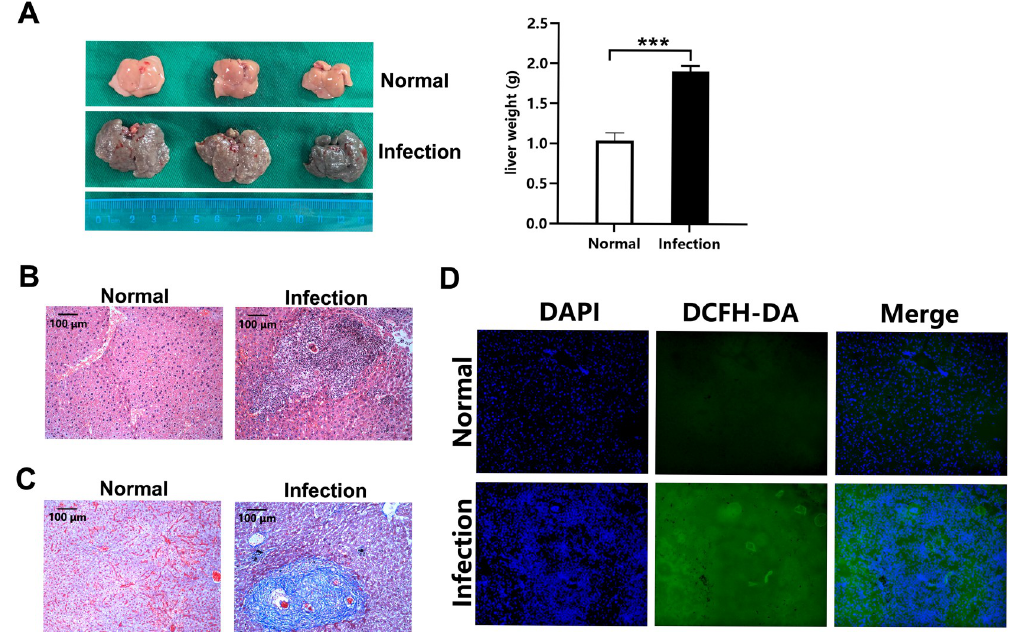
Fig 1. Increased ROS are accumulated in the livers of S . japonicum -infected mice. (A) Representative images of mouse livers from normal (uninfected) or S . japonicum -infected mice are shown. The bar graphs show the average liver weight (g) of mice. (B and C) Representative images of H&E (B) or Masson’s trichrome (C) stained liver sections obtained from normal or infected mice are shown (original magnification, 100-fold; scale bar, 100 μ m). (D) Immunofluorescence of frozen liver sections from normal or infected mice for nuclei using DAPI (blue) and ROS using DCFH-DA (green). (original magnification, 200-fold). Images and data expressed as the means ± SD of five mice per group are representative of three independent experiments. ��� P <